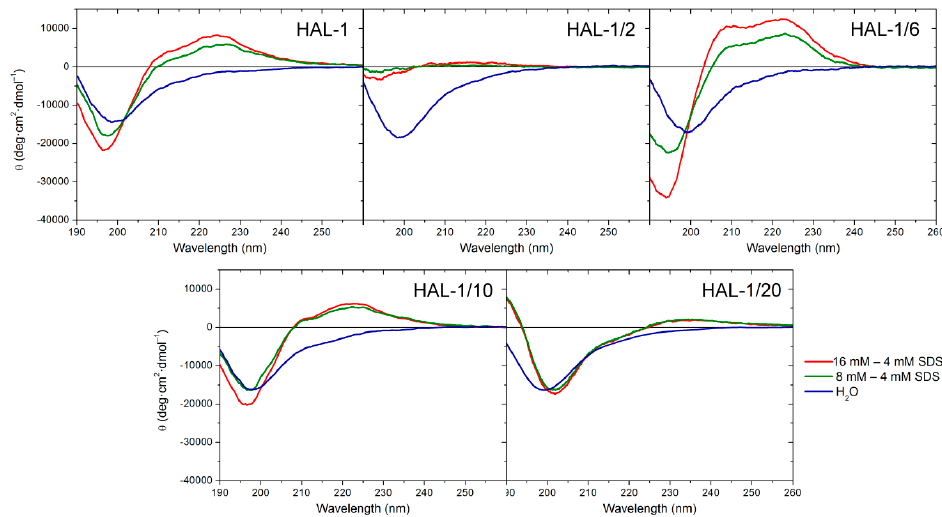
Figure 2. Difference of ECD spectra of HAL-1 and its analogs (0.125 mg/mL) in 8 mM SDS and in 16 mM SDS. ECD spectrum of the sample with the highest α -helical content in SDS solution (4 mM SDS peptide solution for HAL-1/2, HAL-1/6, HAL-1/10, and 0.16 mM SDS peptide solution for HAL-1/20 is taken as a reference). ECD spectra of the peptides in aqueous solution are depicted for comparison.